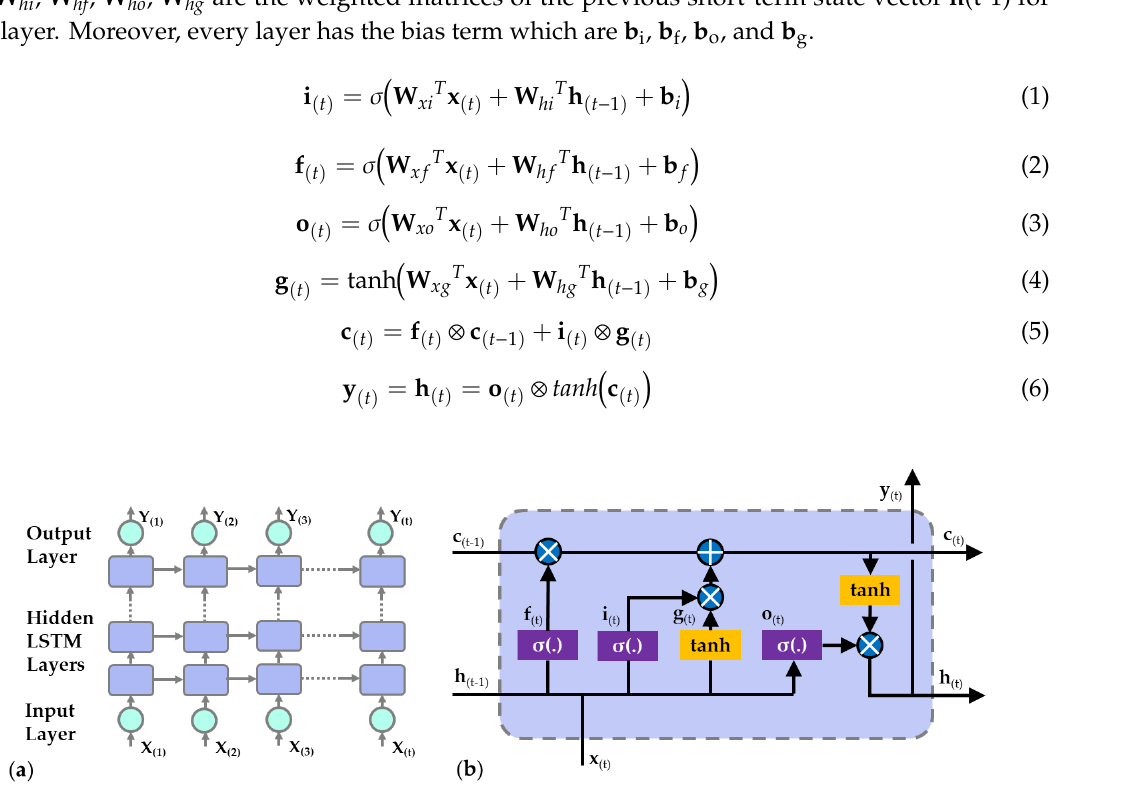
Figure 8. Schematic representation of: ( a ) deep LSTM network through time, and ( b ) LSTM cell Figure8. Schematicrepresentationof: ( a )deepLSTMnetworkthroughtime,and( b architecture.